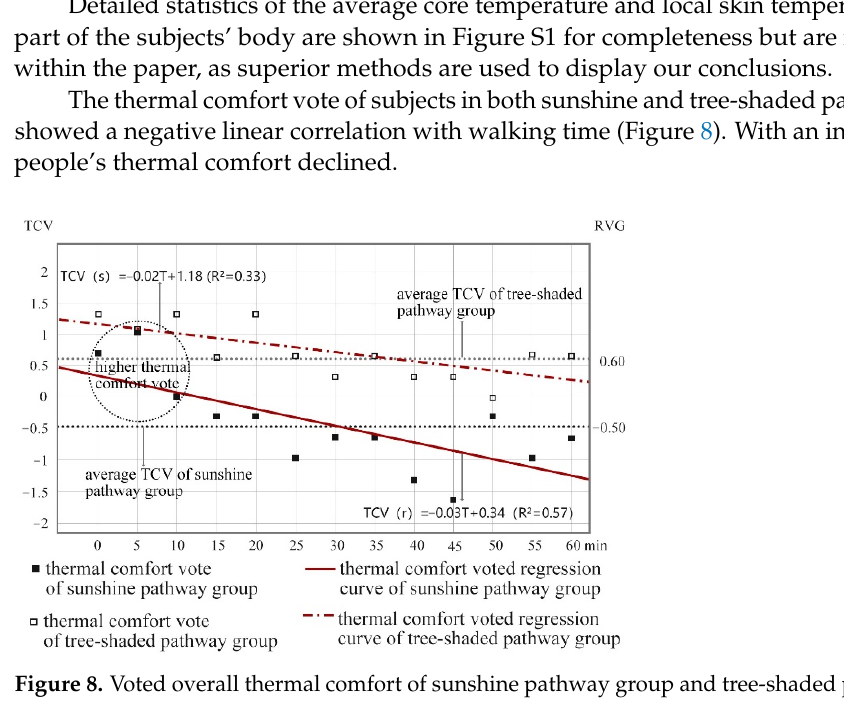
Figure 8. Voted overall thermal comfort of sunshine pathway group and tree-shaded pathway